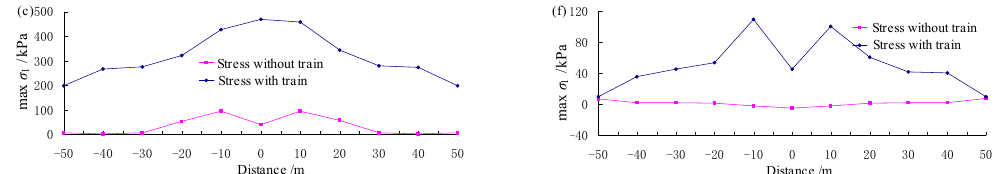
Figure 9. Distribution of secondary lining σ 1 along the longitudinal direction of the tunnel: ( a ) arch of upper tunnel, ( b ) side wall of upper tunnel, ( c ) inversion of upper tunnel, ( d ) arch of lower tunnel, ( e ) side wall of lower tunnel, and ( f ) inversion of lower tunnel.